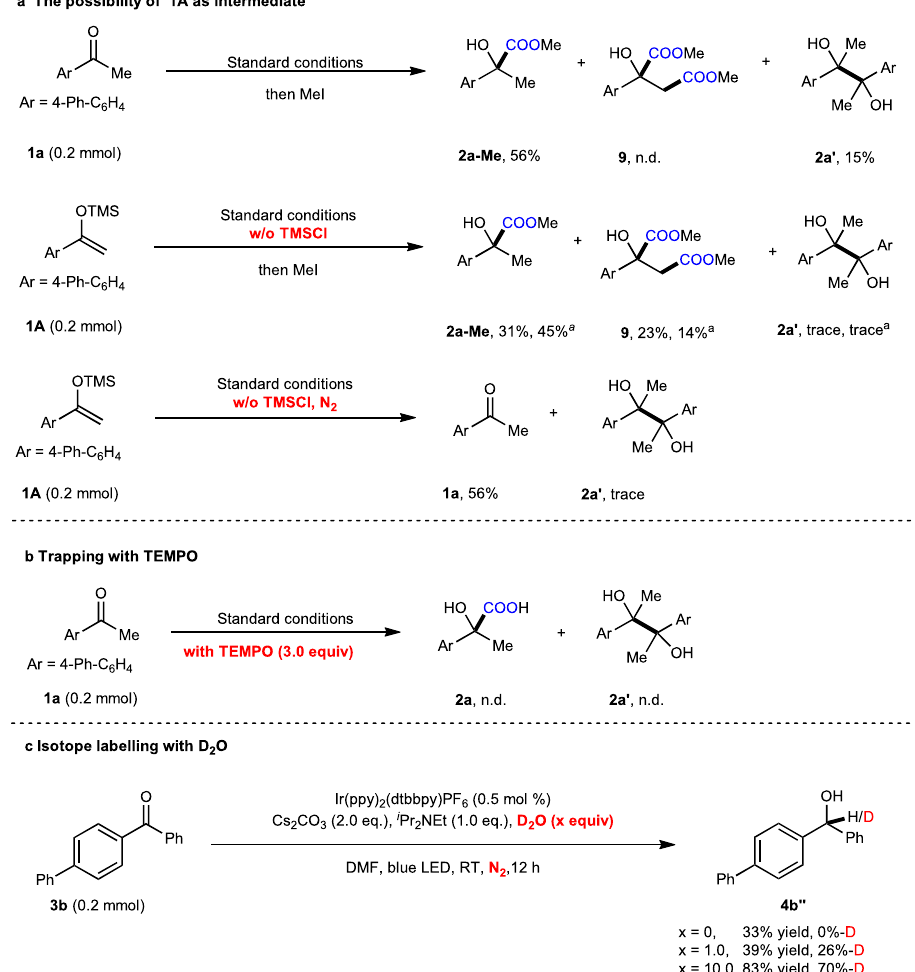
Fig. 8 Control experiments. Isolated yields are shown. a Investigation of the possibility with sily enol ether 1A as intermediate. b Investigation of the effect of radical scavenger in the reaction. c Investigation of the effect of D 2 O in the reaction. a KO t Bu (1.0 equiv) was